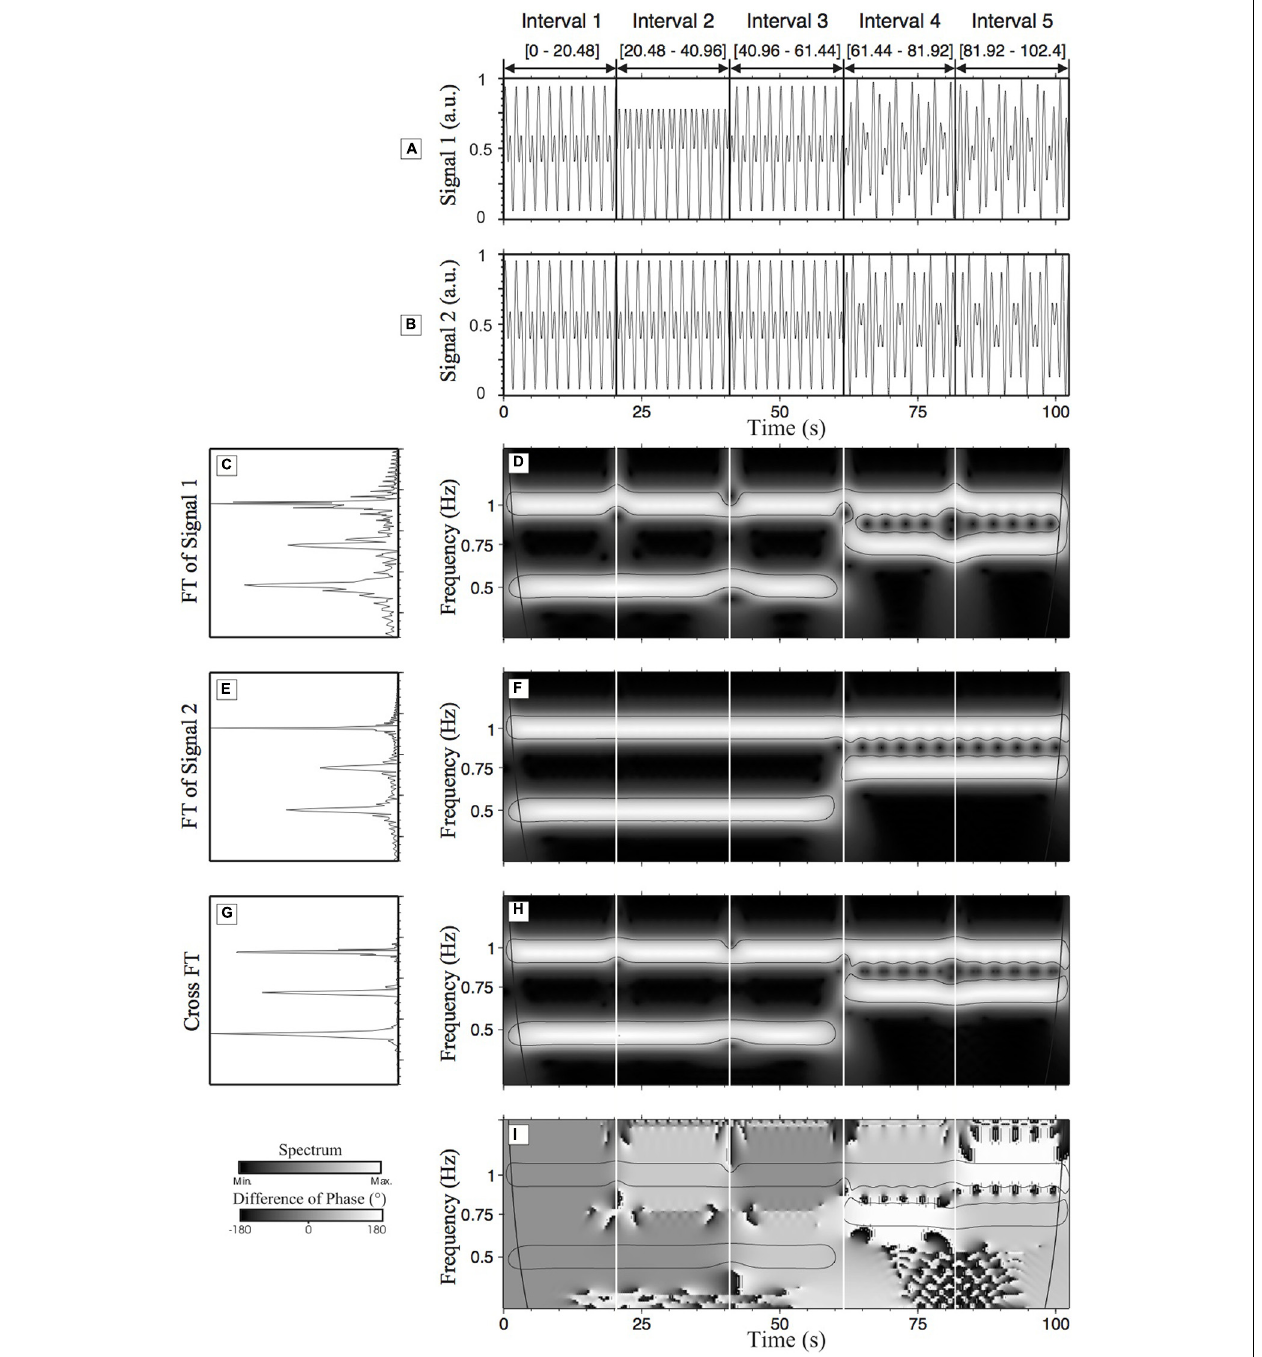
time-series s1 and s2: one frequency at 1 Hz and one at 0.5 Hz. In the two last intervals, there are two frequencies: the frequency at 1 Hz, as in the three first intervals, and a new intermediate frequency at 0.75 Hz. (G) shows the cross-Fourier spectrum of (C,E) . (H) Shows the cross-wavelet spectrum that is a representation of the common frequencies of (D,F) reflecting the local degree of interaction between the two analyzed time-series s 1 and s 2 . (I) Shows the difference of phase of (A,B) , i.e., the difference of phase between s1 and s2. The levels of gray permit us to visualize the associated relative phase (RP). a.u., arbitrary